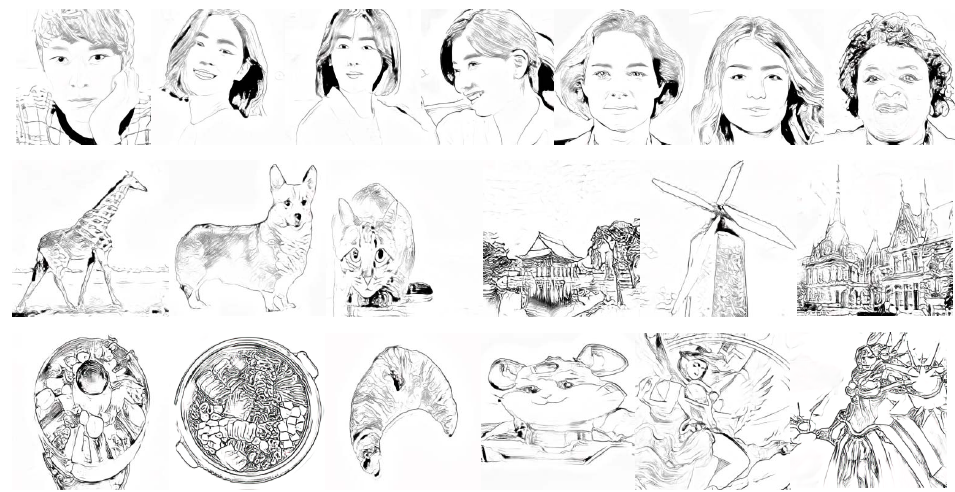
Figure 10. Our illustrative sketch images from various sources including portraits, animals, land- scapes, still-lifes and synthesized